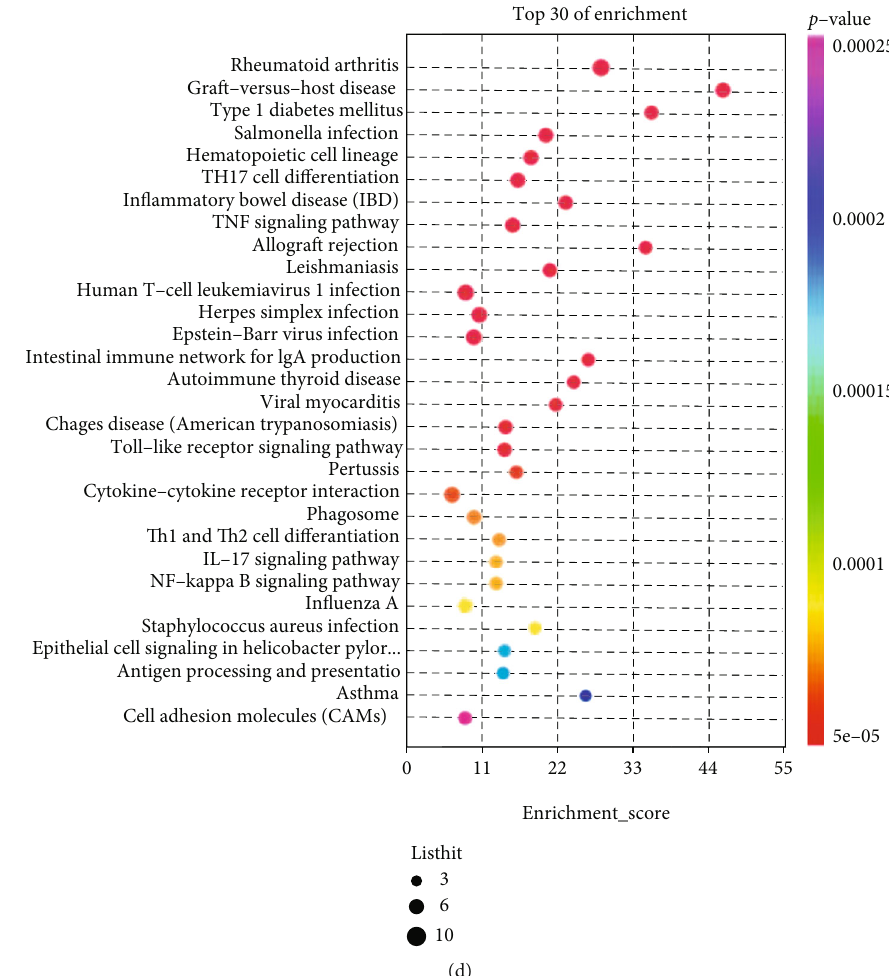
Figure 2: Di ff erential expression analysis and enrichment analysis in GSE116626. (a) Volcano map of all DEGs of GSE116626: 245 DEGs were identi fi ed with P < 0 : 05 and ∣ log foldchange ∣ >1 , including 160 upregulated and 85 downregulated genes. (b) Venn diagram of DEGs 2 and IRGs: 34 DIRGs were identi fi ed. (c) Top 30 GO functional enrichment of 34 DIRGs. Biological process (BP, circle), cellular component (CC, square), and molecular function (MF, triangle) analysis results of 34 DIRGs. (d) Top 30 KEGG functional enrichment of 34 DIRGs. The size of the graph represents the number of genes, and the x -axis represents the enrichment